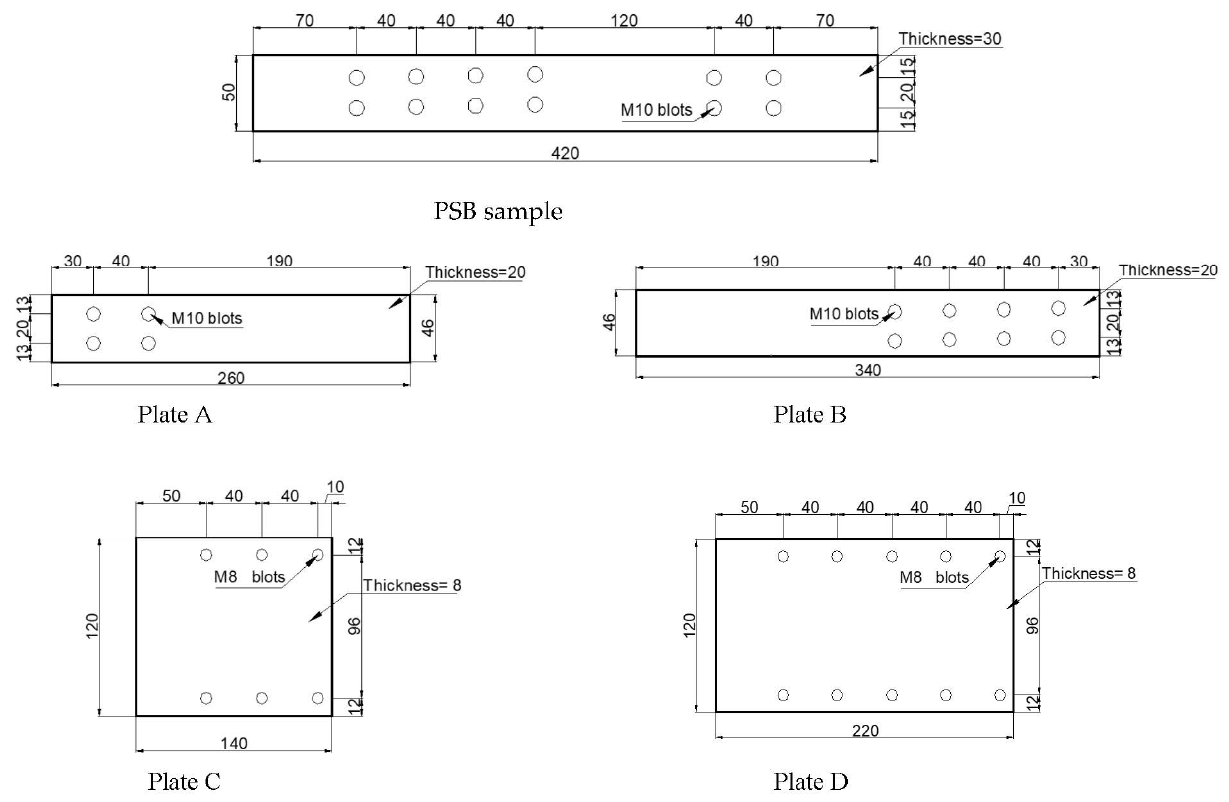
Figure 5. Sizes and details of the plates labelled in Figure 4.